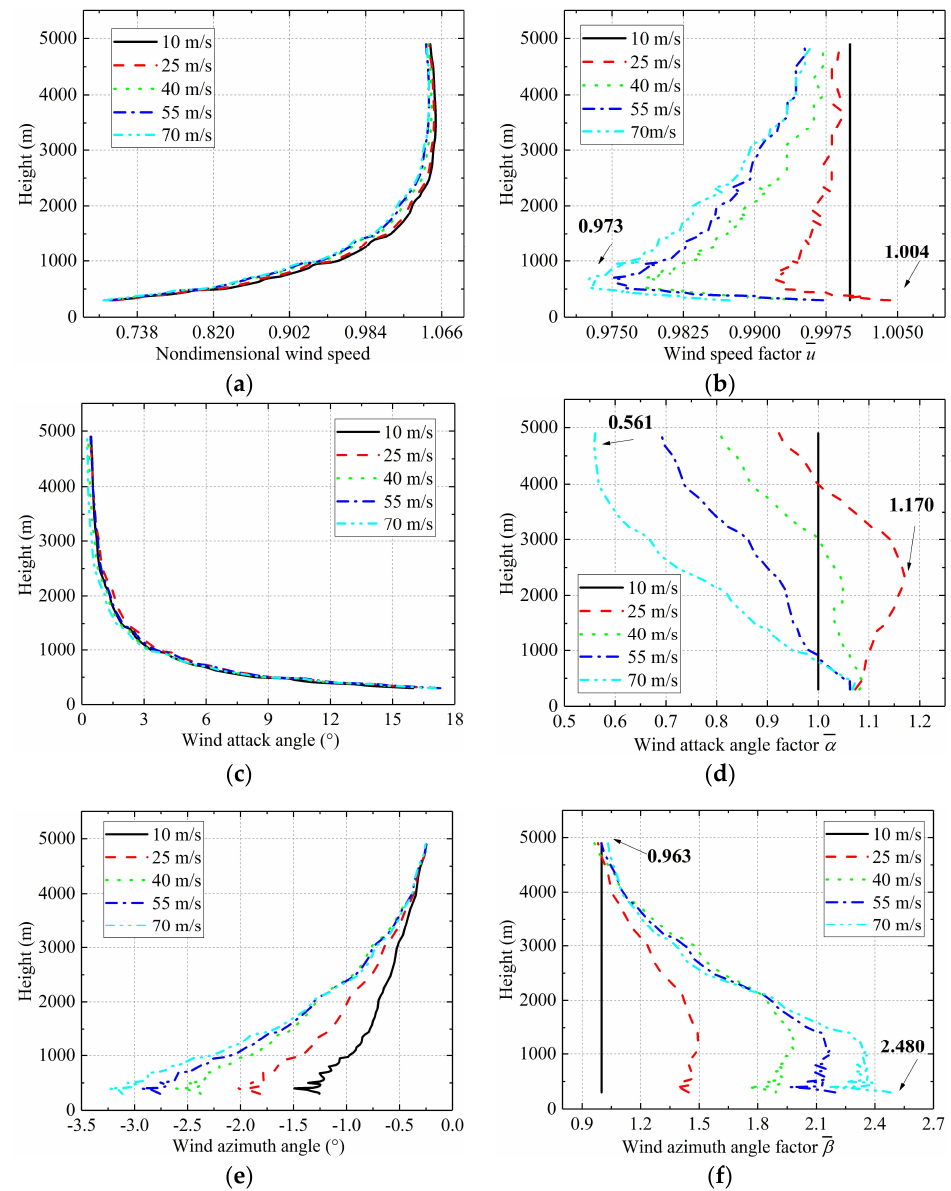
Figure 6. Influence of inlet wind speed on wind parameters: ( a ) Nondimensional wind speed profile; ( b ) Nondimensional wind speed factor; ( c ) Wind attack angle profile; ( d ) Wind attack angle factor; ( e ) Wind azimuth angle; ( f ) Wind azimuth angle factor.